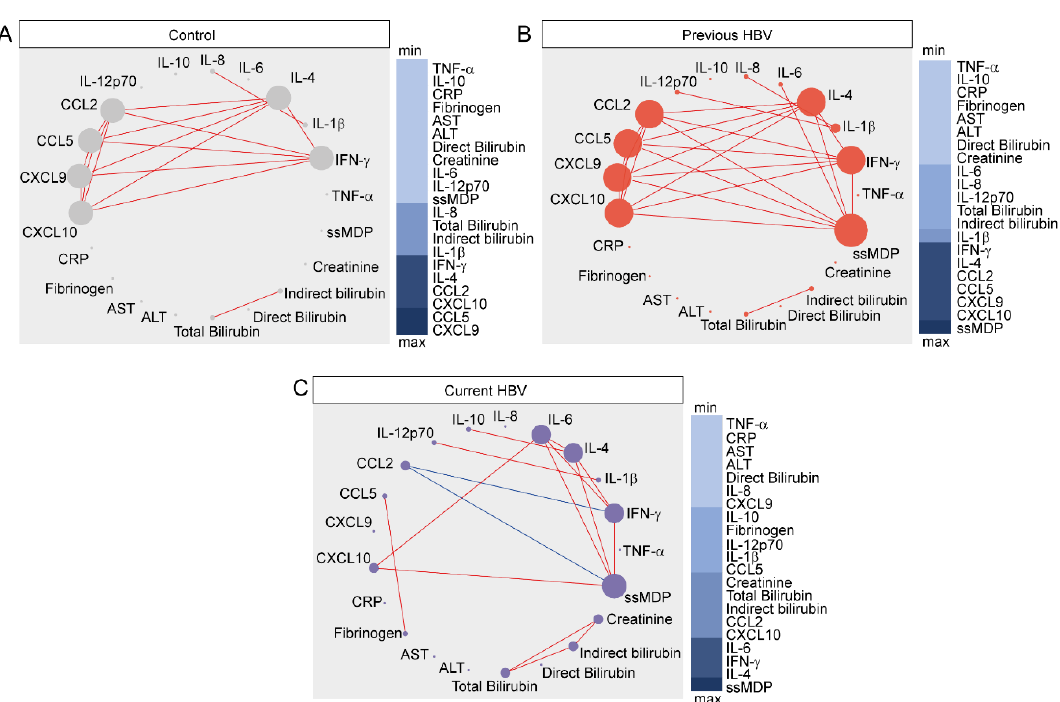
Figure 3. Network analysis of the MDP score matrices in the study groups. Spearman correlation matrices of the MDP score values in each study group (( A ) controls; ( B ) previous HBV; ( C ) current HBV) were built and Circos plots were used to illustrate the correlation networks. Only significant correlations ( p < 0.05) are shown. Each circle represents a different plasma parameter and the size of each circle is proportional to the number of significant correlations. Lines represent the Spearman rank (rho) values. Red color infers positive correlation, whereas blue color denotes negative correlation. Node analysis heatmap shows the number of statistically significant correlations involving each marker per clinical group. Abbreviations (alphabetic order): ALT: alanine aminotransferase; AST: aspartate aminotransferase; CCL: C-C motif chemokine ligand; CXCL: C-X-C